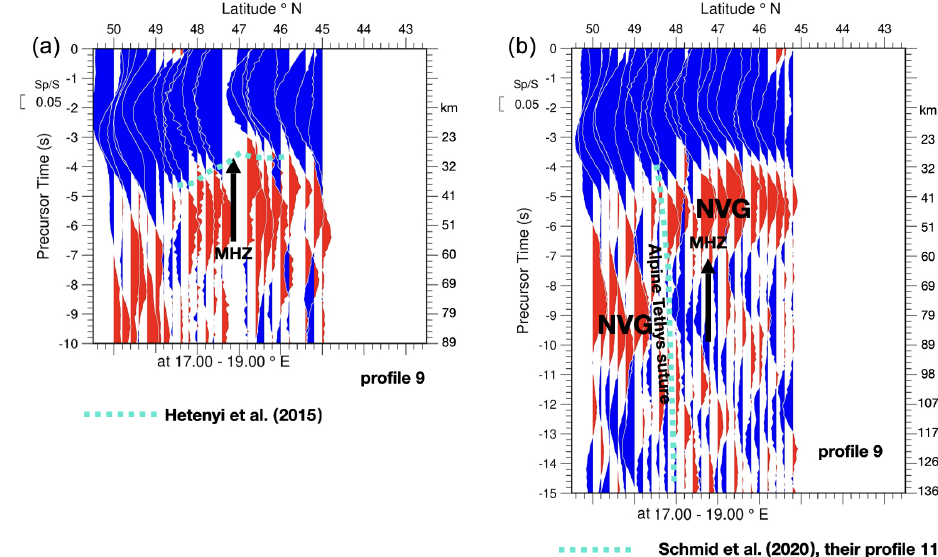
Figure 19. (a) Copy of profile 9 (Fig. 11a) across the MHZ superimposed with a study by Hetényi et al. (2015) who used P-receiver functions. (b) Copy of profile 9 (Fig. 11b) superimposed with the location of the Alpine Tethys suture as interpreted by Handy et al. (2021) based on mantle tomography by Paffrath et al. (2021).